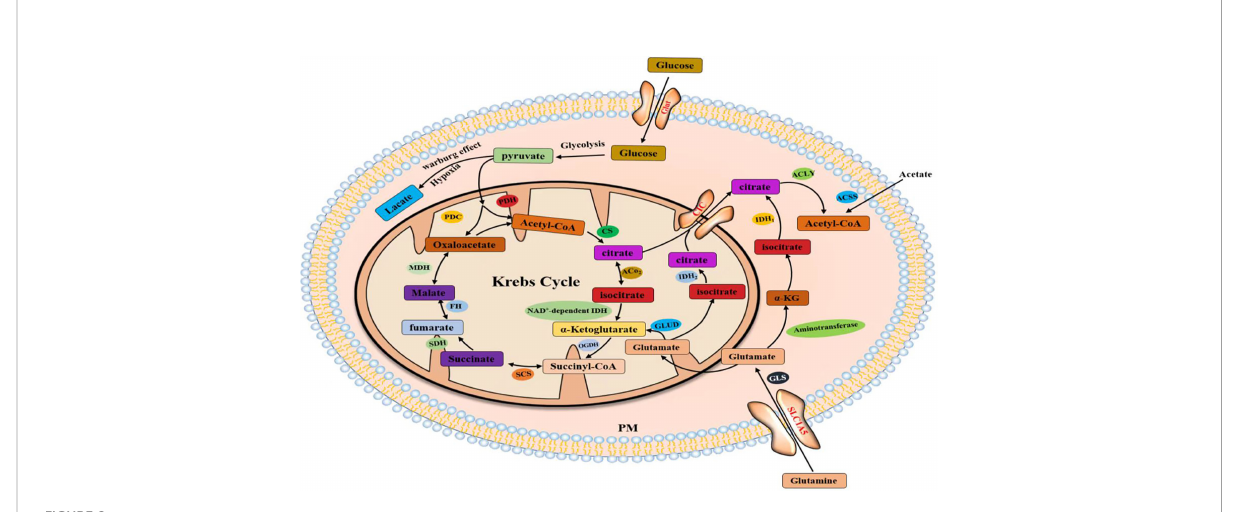
FIGURE 2 Acetyl-CoA production in the cytoplasm comes from three